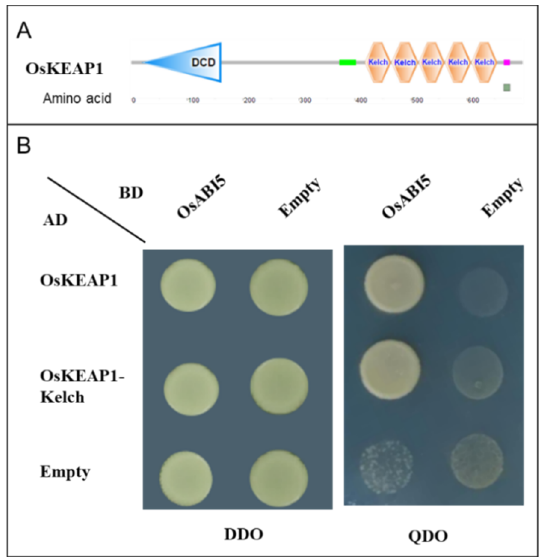
Figure 1. Yeast two-hybrid (Y2H) analysis of OsKEAP1 and its Kelch repeat domain (OsKelch) with OsABI5. ( A ) Diagram of OsKEAP1 showing the position of the OsKelch domain. Prediction of the domains was performed at https://smart.embl.de/ (accessed on 5 March 2021). DCD: Development and Cell Death. The green and pink/red boxes represent the coiled coil region and low-complexity region, respectively. ( B ) Y2H analysis. Yeast cells were transformed with BD-OsABI5 and AD- OsKEAP1 or AD-OsKelch, as indicated. Yeast cells were incubated on DDO (double dropout: SD/-Leu/-Trp) and QDO (quadruple dropout: SD/-Ade/-His/-Leu/-Trp) plates for 5 days.